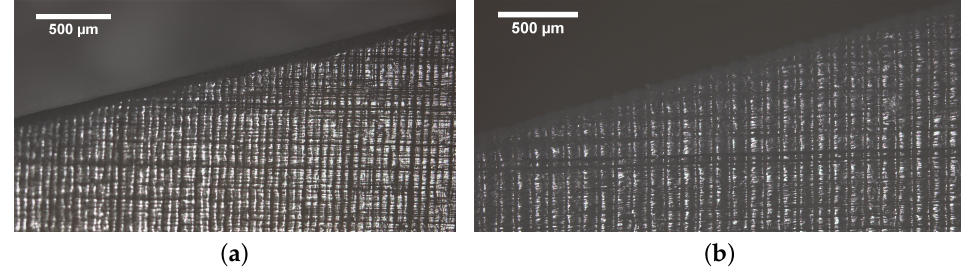
Figure 10. Effect of the Layer height in the surface finishing in samples printed at 75 ◦ . ( a ) 50 µ m; ( b ) 100 µ m.